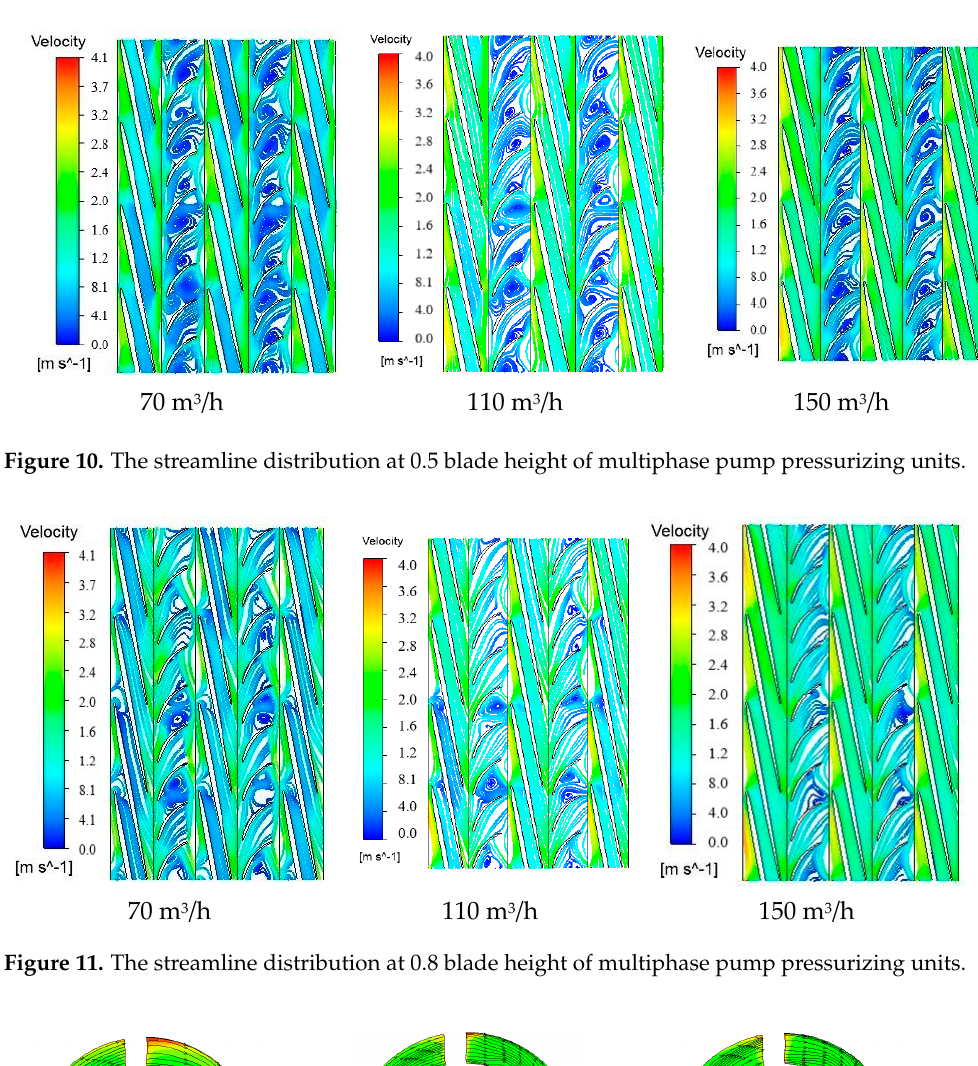
Figure 11. The streamline distribution at 0.8 blade height of multiphase pump pressurizing units.